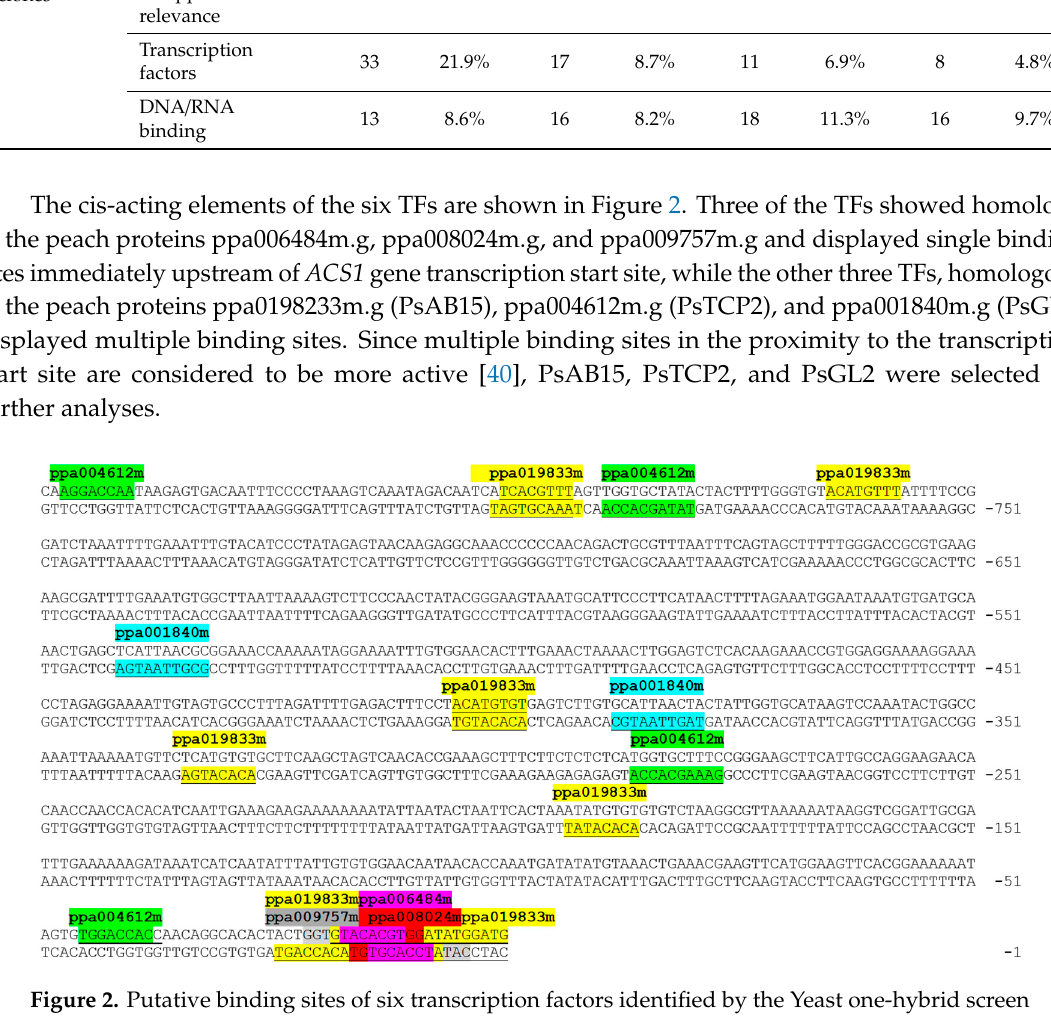
Figure 2. Putative binding sites of six transcription factors identified by the Yeast one-hybrid screen and predicted by PlantPAN in the promoter region of ACS1 gene. The various transcription factors (TFs) are indicated by their Prunus persica protein ID above their putative binding sites. Binding sites of the same transcription factor are marked with same color.